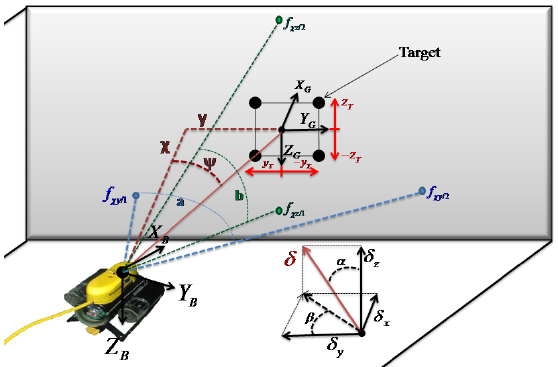
Figure 4. Visibility constraints formulation Equations (8b)–(8e) and modeling of the external disturbance Equation (5), c (cid:13) 2014 IEEE